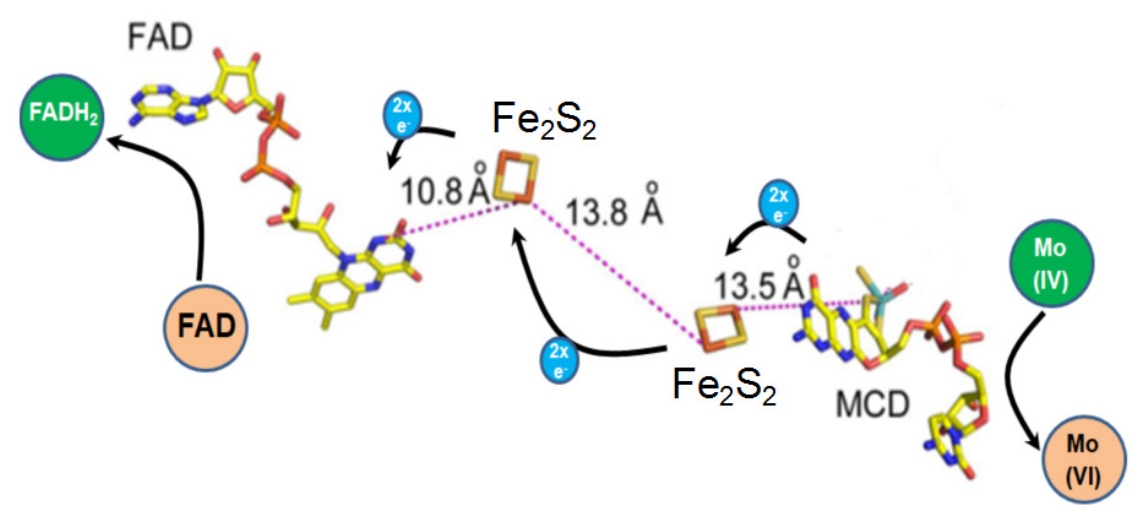
Figure 3. The cofactors of Kdh are arranged in a linear fashion, with distances between adjacent cofactors less than 14 Å. The MCD, the 2 Fe 2 S 2 iron-sulfur clusters and the FAD cofactors of Kdh are shown in stick representations, with distances between adjacent cofactors labeled.